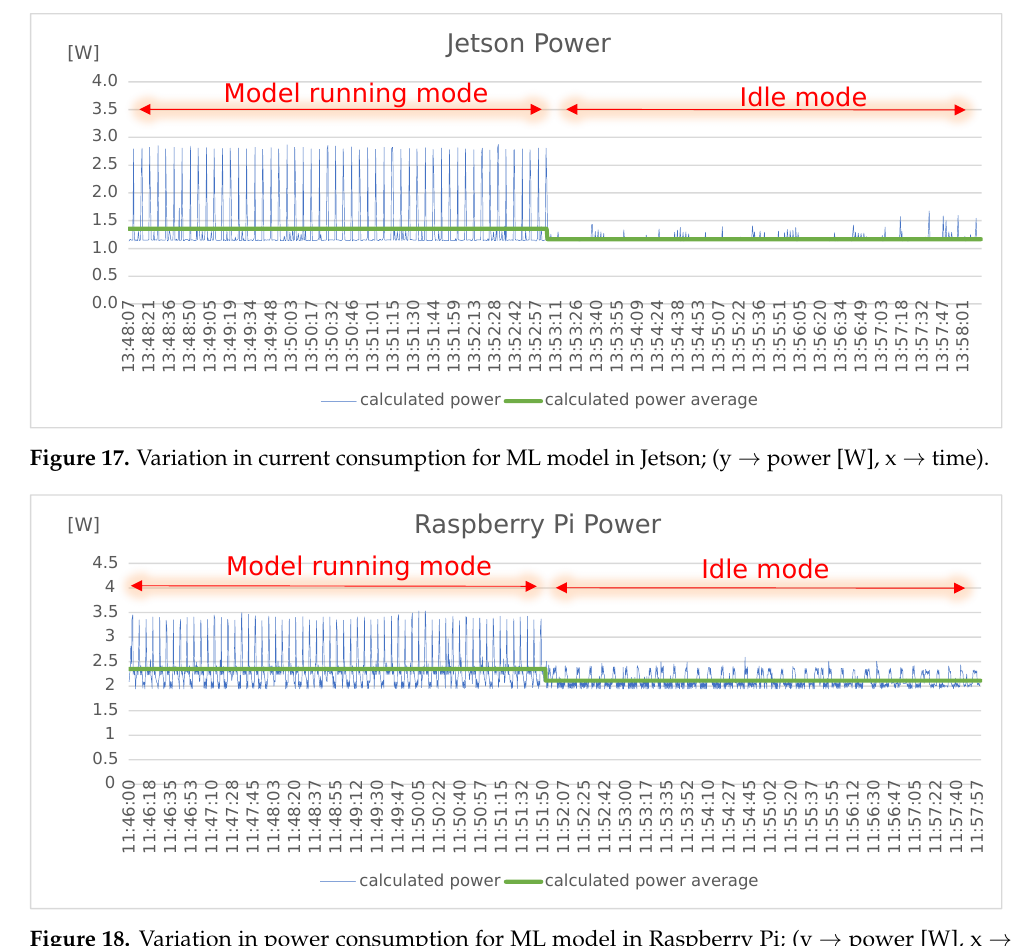
Figure 18. Variation in power consumption for ML model in Raspberry Pi; (y → power [W], x →